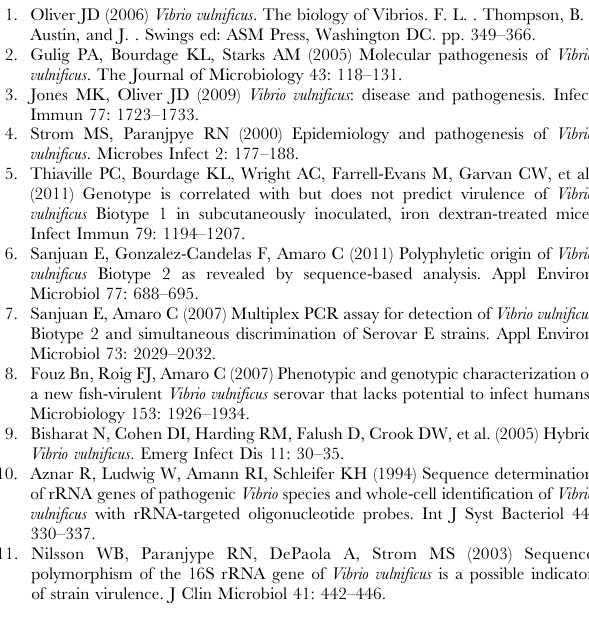
Figure S4 Arylsulfatase A majority-rule consensus tree based on the genealogies inferred by Clonal Frame after 100000 iterations (including 50000 burn-in iterations), mutation rate h = 5 and recombination rate r =5. (TIF) Figure S5 MtlABC unrooted neighbor joining tree; Kimura’s 2-parameter distance, 1000 bootstraps repli- cates. (TIF) Figure S6 MtlABC majority-rule consensus tree based on the genealogies inferred by Clonal Frame after 100000 iterations (including 50000 burn-in iterations), mutation rate h = 5 and recombination rate r =5. (TIF) Figure S7 NanA unrooted neighbor joining tree; Ki- mura’s 2-parameter distance, 1000 bootstraps repli- cates. (TIF) Figure S8 NanA majority-rule consensus tree based on the genealogies inferred by Clonal Frame after 100000 iterations (including 50000 burn-in iterations), mutation rate h = 5 and recombination rate r = 5.